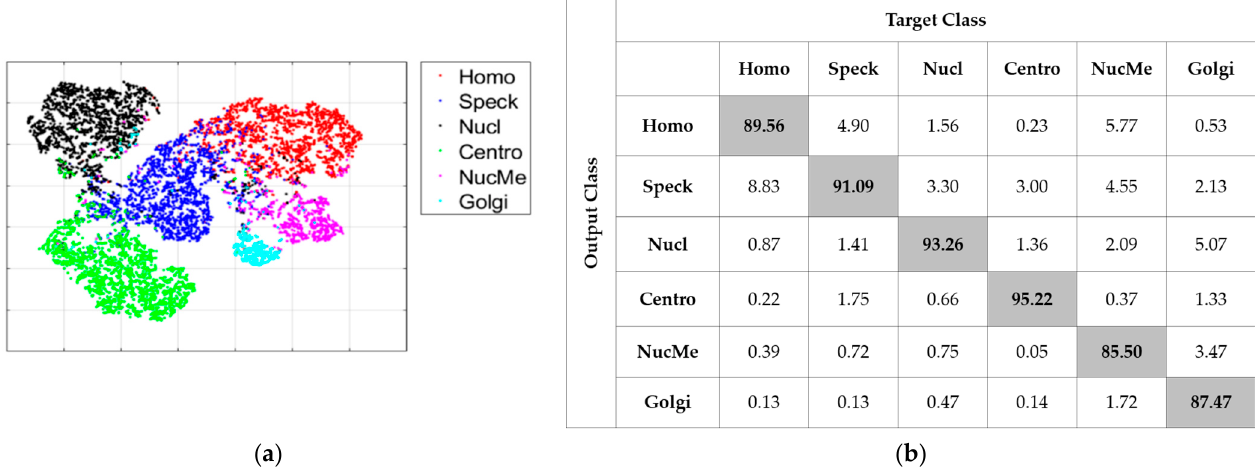
Figure 12. Classification results of the “AL” case: ( a ) features’ visualization and ( b ) confusion matrix.